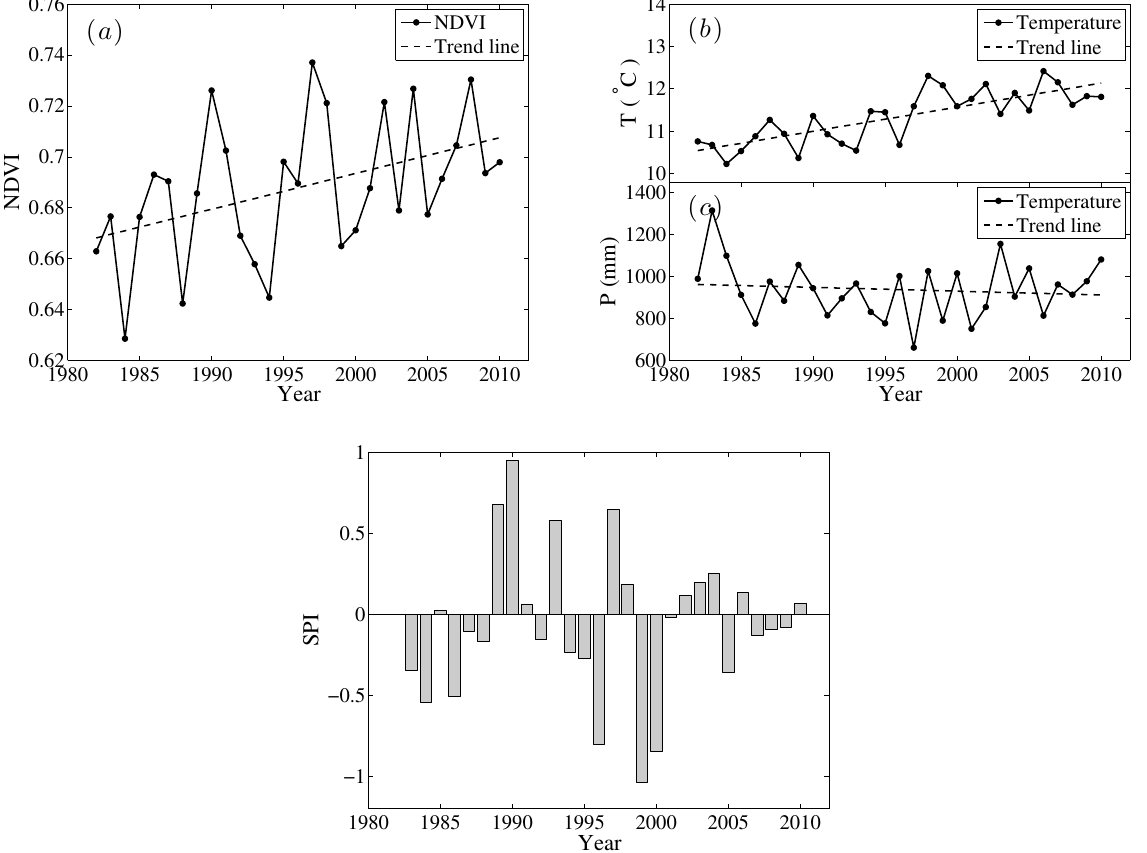
Figure 13. ( a ) Mean NDVI; ( b ) mean temperature; ( c ) accumulate precipitation in the growing season and ( d ) mean SPI in winter and spring in Central China from 1982 to 2010. (3) Central